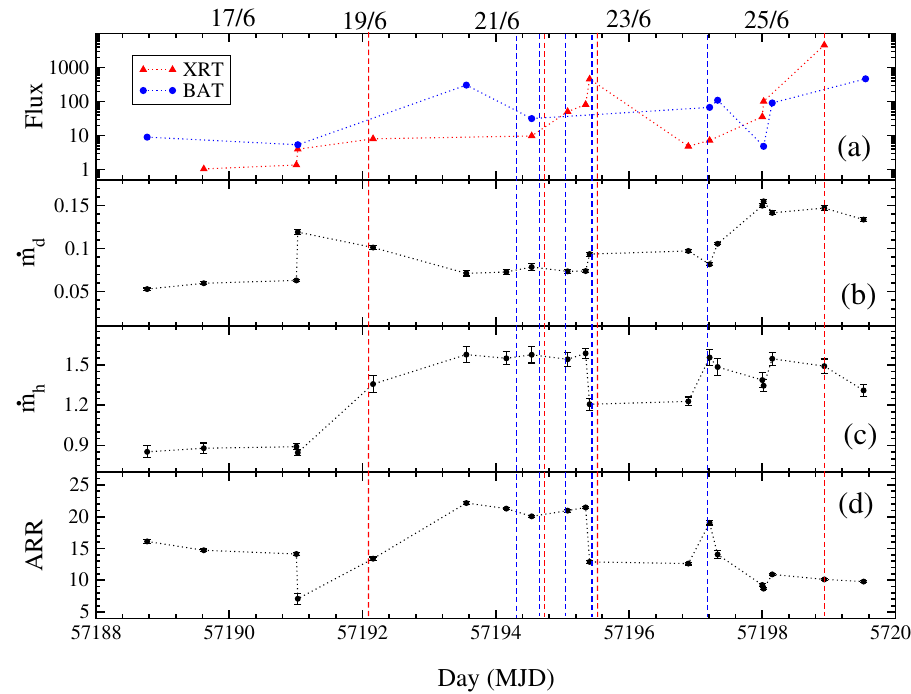
Figure 6. Panel ( a ) shows variation of 0.5–10 keV XRT and 15–150 keV BAT flux with day (MJD). The red (online) triangle represents XRT flux while blue (online) circle represents BAT flux. The fluxes are in the unit of 10 − 9 erg cm − 2 s − 1 . The variation of ( b ) ˙ m d in ˙ M Edd and ( c ) ˙ m h in ˙ M Edd are shown with day (MJD). In panel ( d ) the variation of ARR (= ˙ m h / ˙ m d ) is shown. Blue and red dotted lines represent reported X-ray and Radio flaring activities, respectively.